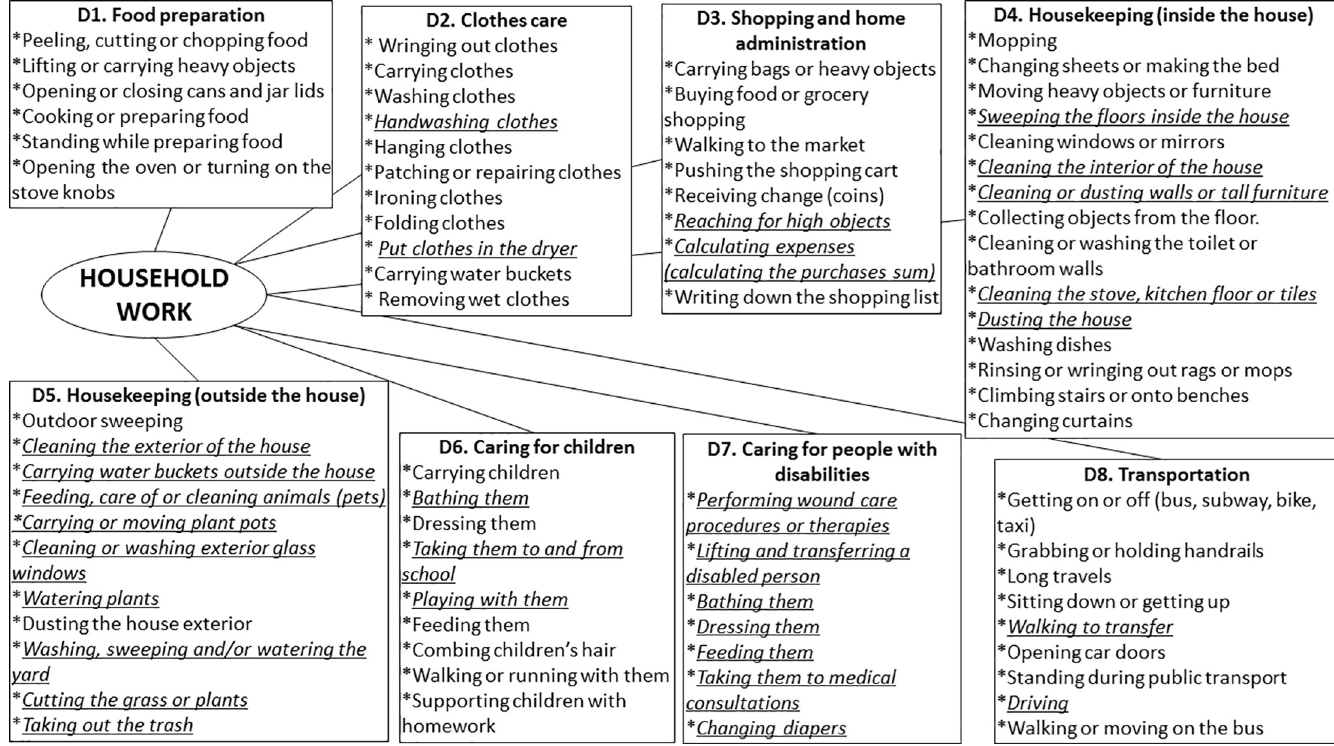
Fig 1. Theoretical household work construct. Tasks/activities deleted from version 1 and